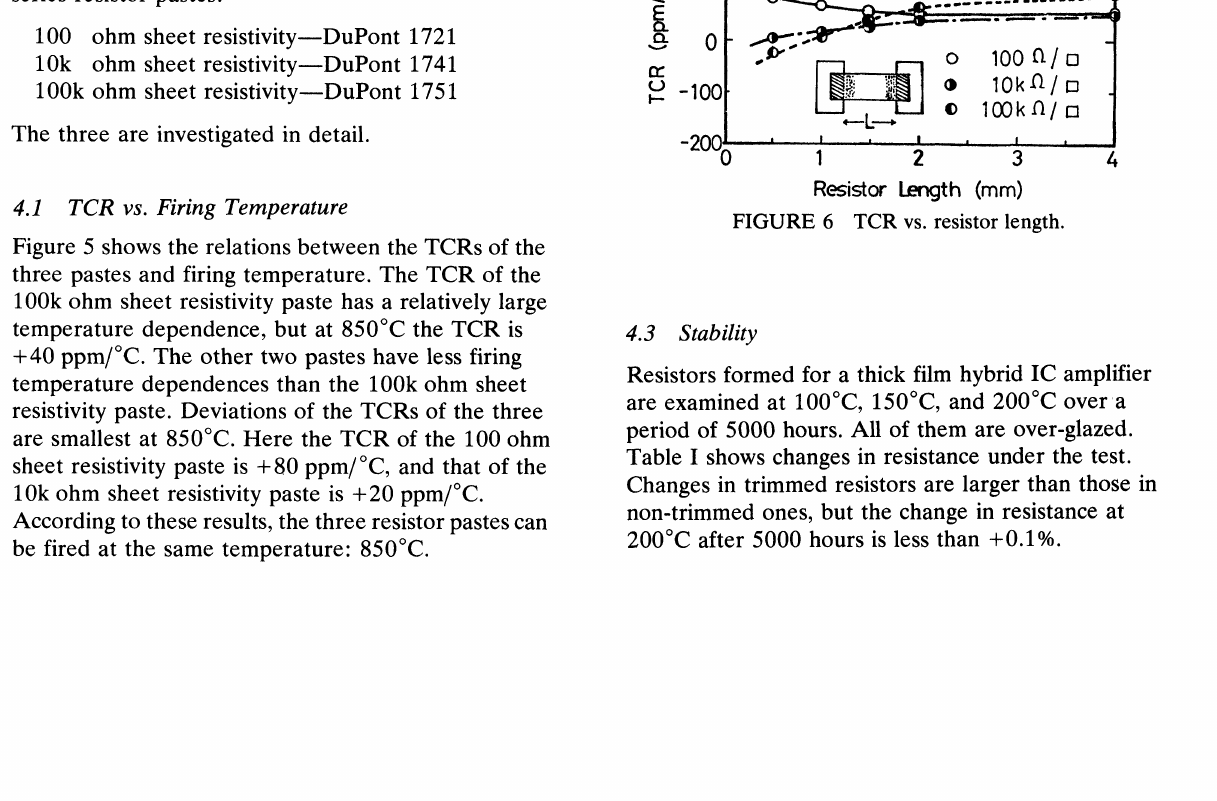
FIGURE 6 TCR vs. resistor